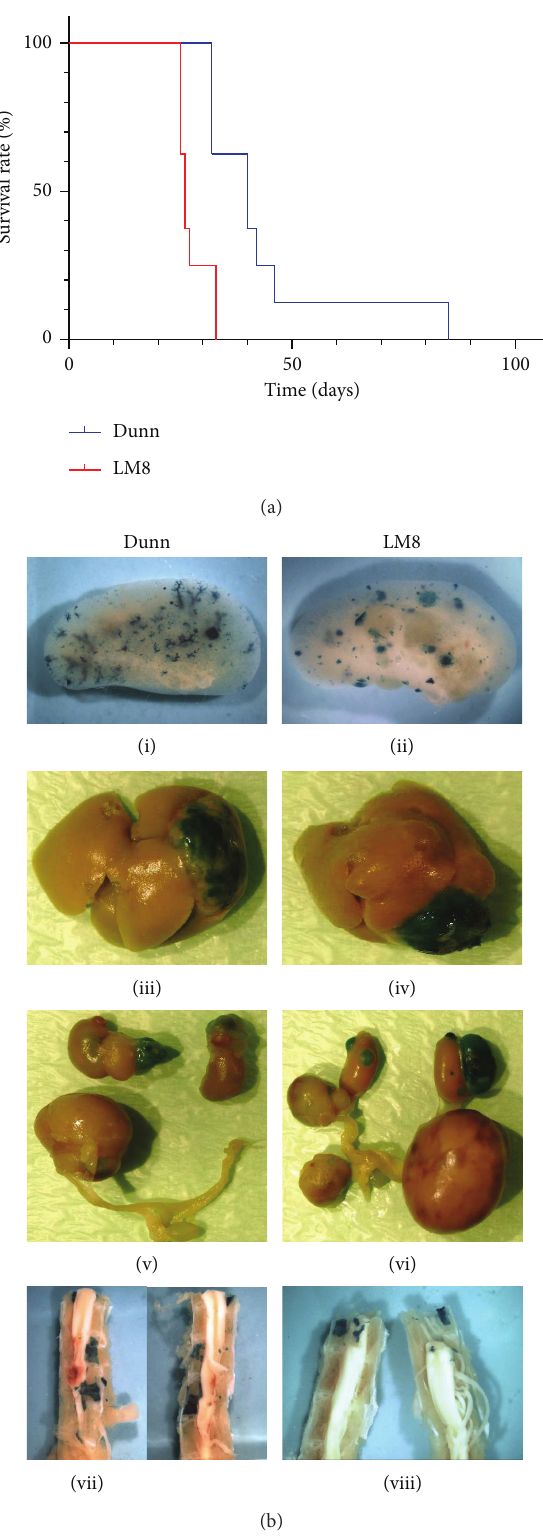
Figure 4: Animal survival and tissue distribution of metastases at sacrifice in mice intravenously injected with lacZ -transduced Dunn or LM8 OS cells. (a) Kaplan-Meier survival curves of C3H mice injected with LM8 (red line) or Dunn (blue line) cells. (b) Metastatic pattern in lung (i-ii), liver (iii-iv), urogenital tract (v-vi), and spine (vii-viii) of moribund mice at